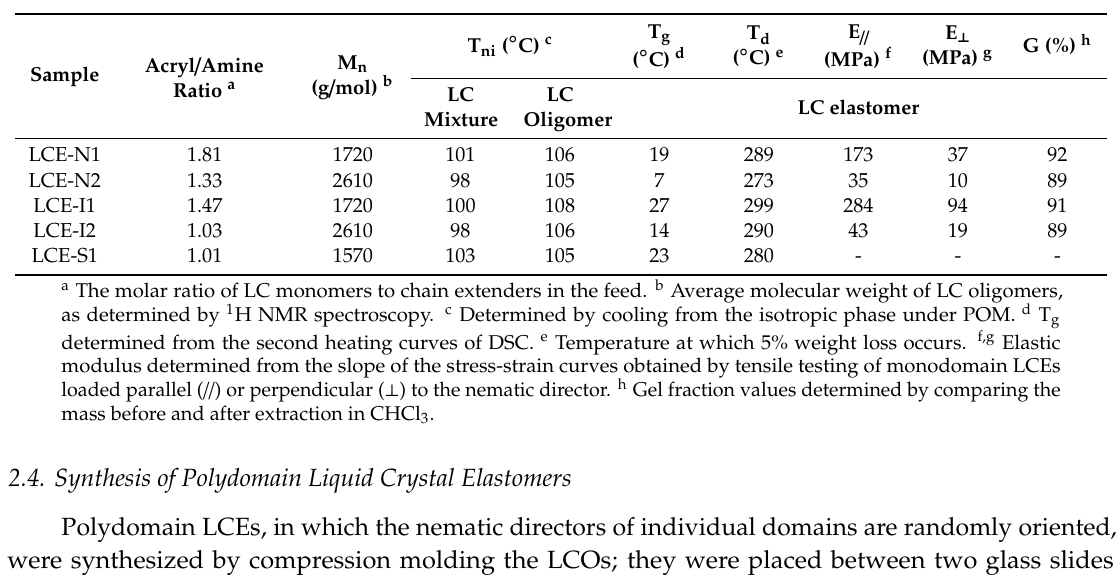
Table 1. Characterization of